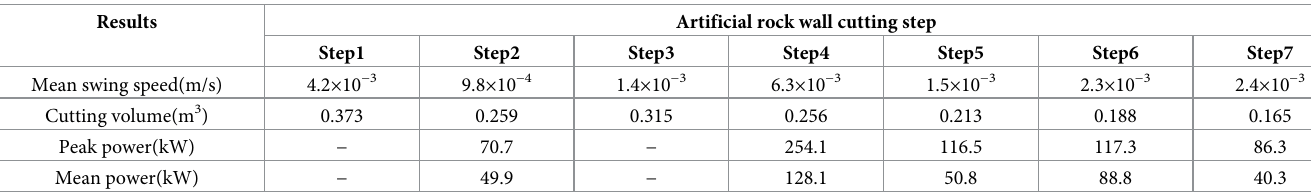
Table 5. Results of each cutting